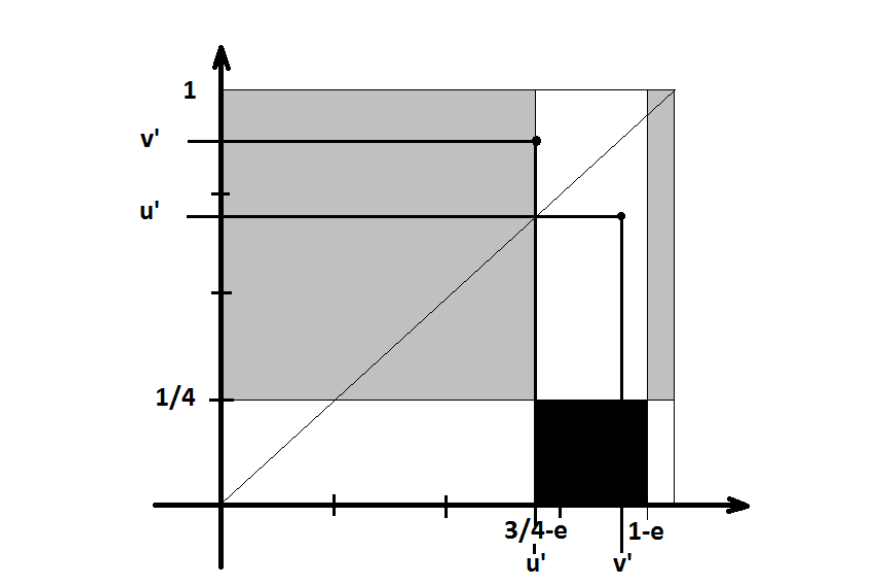
Figure 1: Density of the copula (cid:98) C considered in Example